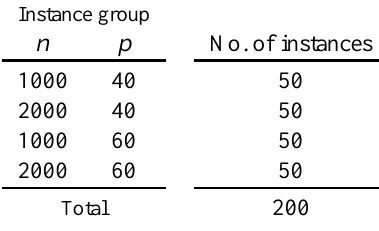
Table 7. Size of test instances.